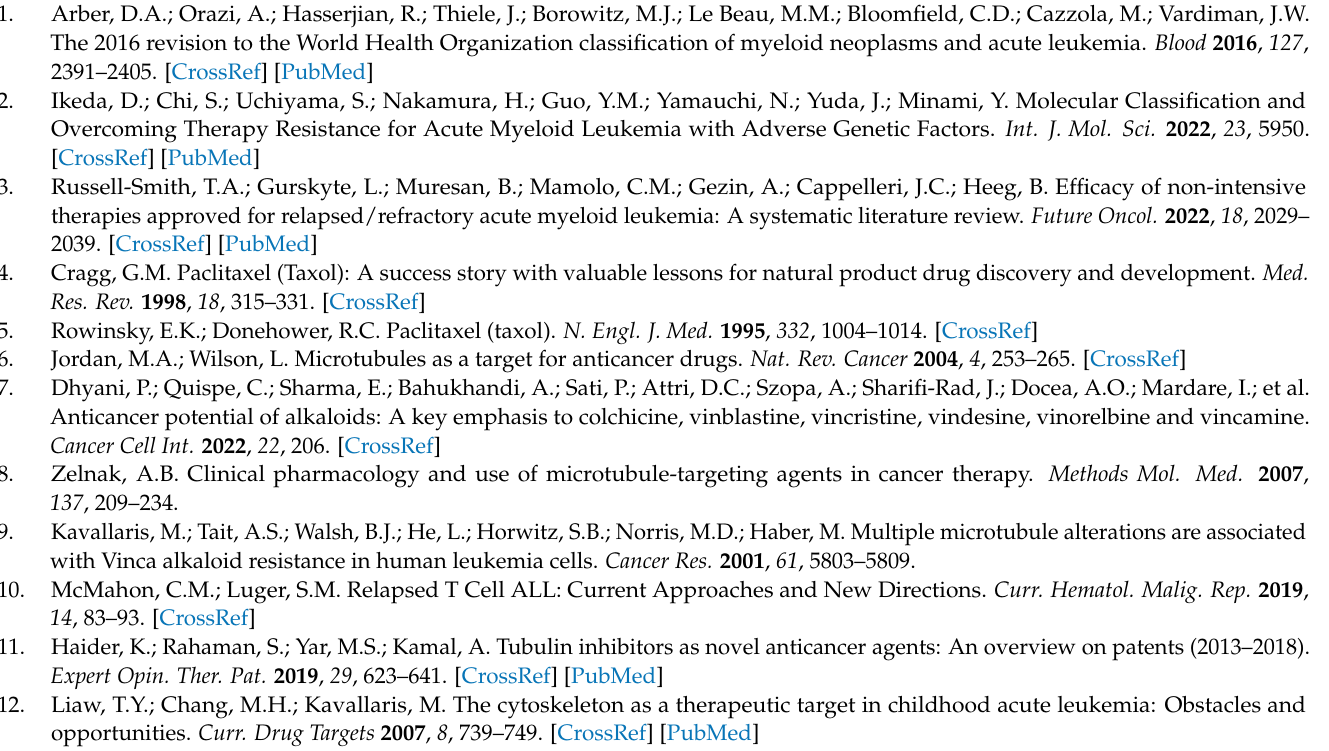
Figure 6; Figure S2: Whole gel images related to Figure 7; Figure S3: The combination of eribulin and elacridar does not impact the cell viability of normal leukocytes; Figure S4: Correlation between TIMP1 and response to eribulin in blood cancer cells; Table S1: Primer sequences and concentrations; Table S2: Cell lines’ characteristics and their sensitivity to